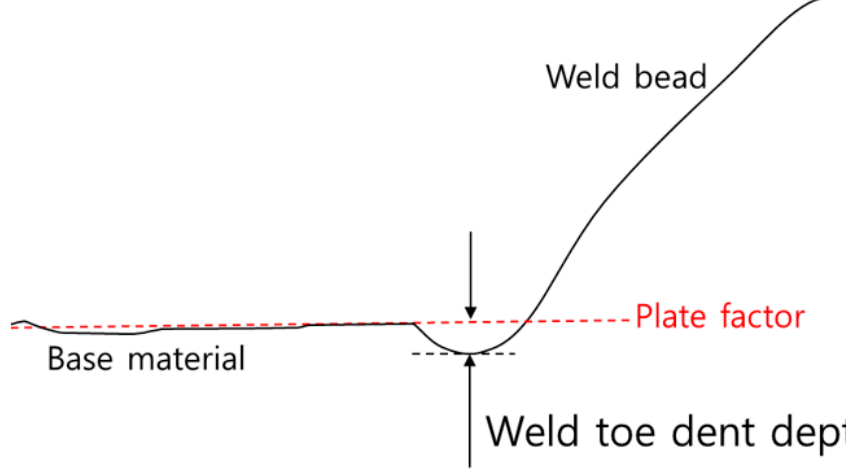
Figure 17. Schematic diagram of the trough depth measurement. Minimum Radius at the Toe